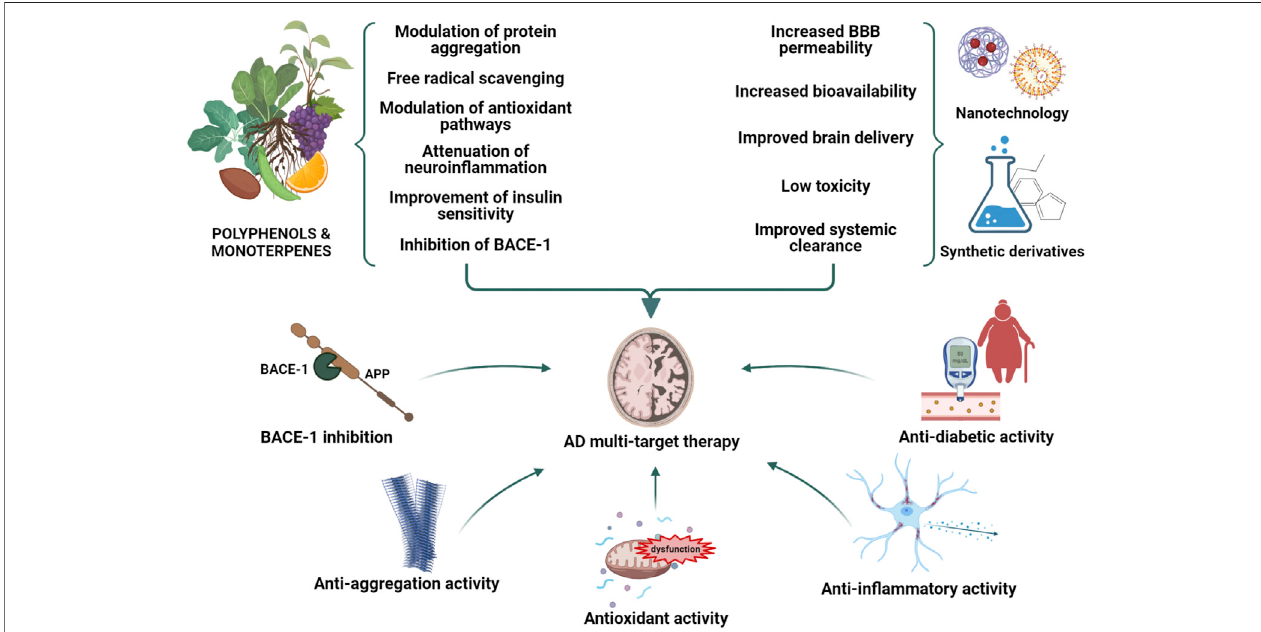
FIGURE 5 | Polyphenols and monoterpenes as potential bioactive agents in Alzheimer ’ s disease (AD) multi-target therapy. Phytochemicals may serve as therapeutic agents to combat AD neurodegeneration owing to their antioxidant and anti-in fl ammatory activities, which may be useful in counteracting oxidative stress and neuroin fl ammation. In addition, they may modulate the Amyloid- β (A β ) aggregation and accumulation hence reducing brain A β burden. The improvement of insulin- sensitivity by phytochemicals may also be bene fi cial for reversing the detrimental progression of AD. The combination of the biological activities of phytochemicals with nanotechnology and/or synthetic strategies may improve their pharmacokinetic pro fi le and their therapeutic potential.